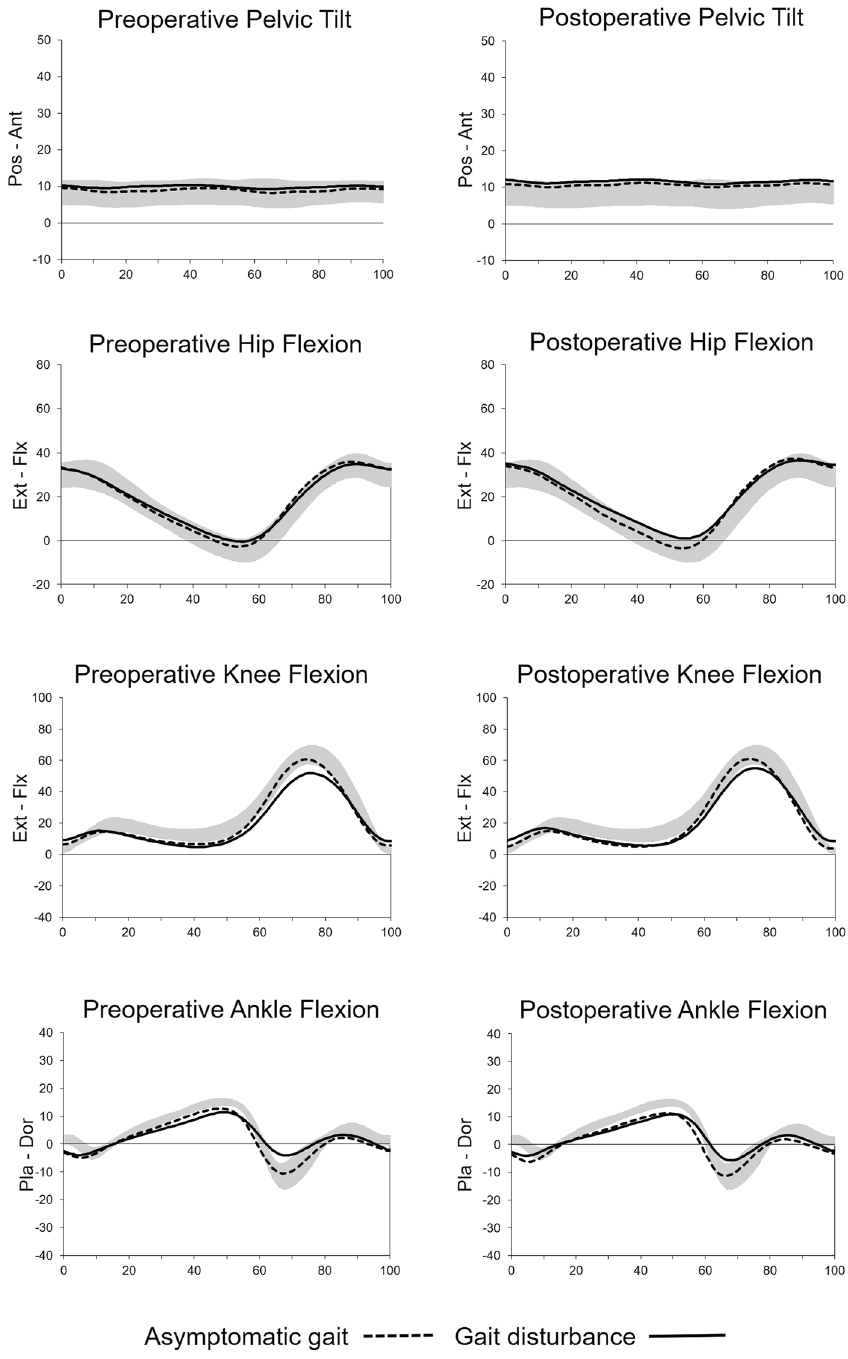
Figure 1. Kinematic graphs of the pelvis, hip, knee, and ankle before and after surgery. Preoperatively, knee flexion during the swing phase and ankle plantarflexion at push-off were decreased in the gait disturbance group compared to the asymptomatic gait group. These factors improved after surgery, but remained lower than in the asymptomatic gait group. In both groups, the ankle angle at initial contact demonstrated plantarflexion both before and after surgery. Ant anterior, Dor dorsiflexion, Ext extension, Flx flexion, Pla plantarflexion, Pos